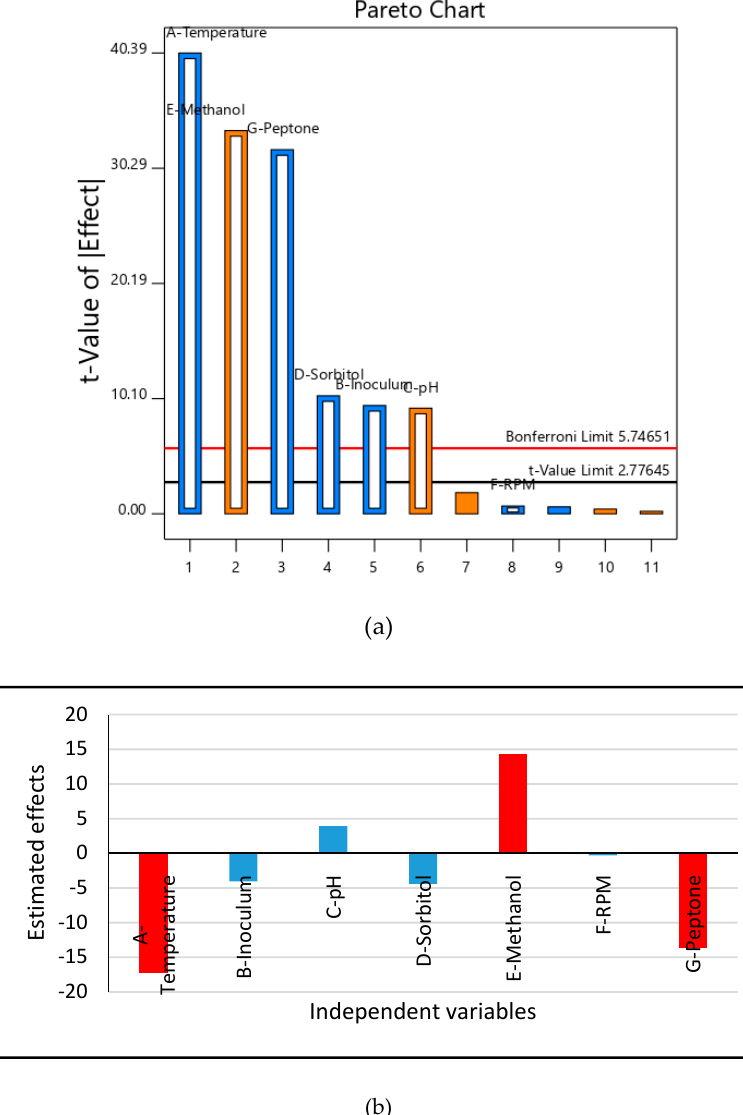
Figure 3. ( a ) Pareto chart obtained from the Plackett-Burman design representing the order and % contributionofeachparameteronproductionofstableHSA.Blueandorangecolorrepresentthenegative andpositivecontributionrespectively. ( b )Estimatede ff ectsofindependentvariablesonHSAproduction by Clone # 14. Red indicate the most significant while blue indicate nonsignificant